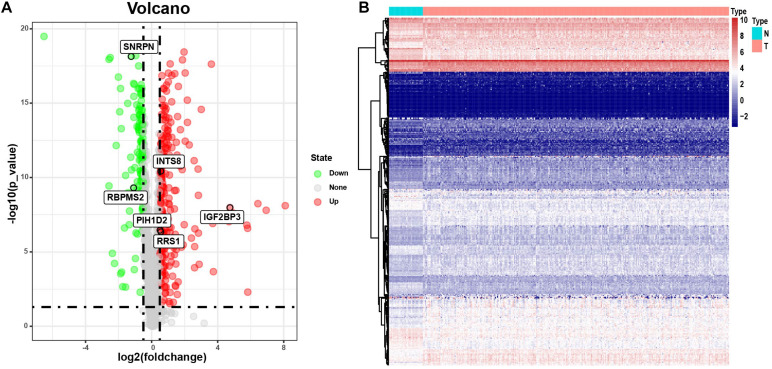
The differentially expressed RBPs. (A) Volcano plot of differentially expressed RBPs reaching the threshold of adj. P < 0.05 and | log2FC| ≥ 0.5. (B) Heatmap plot of 120 differentially RBPs expression between tumor and normal samples in pRCC.